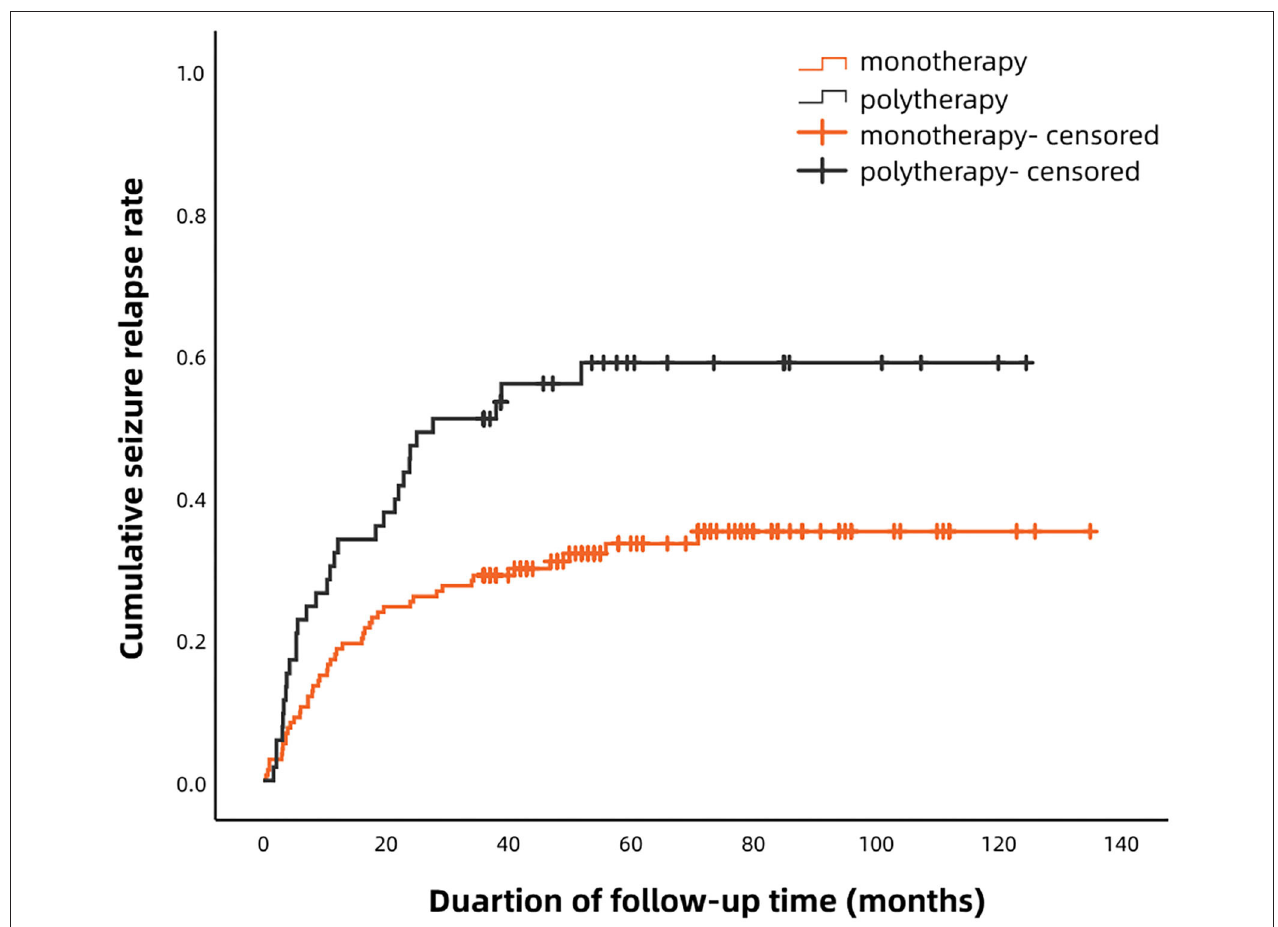
FIGURE 1 | Kaplan–Meier analysis of the cumulative recurrence rates in patients treated with monotherapy and